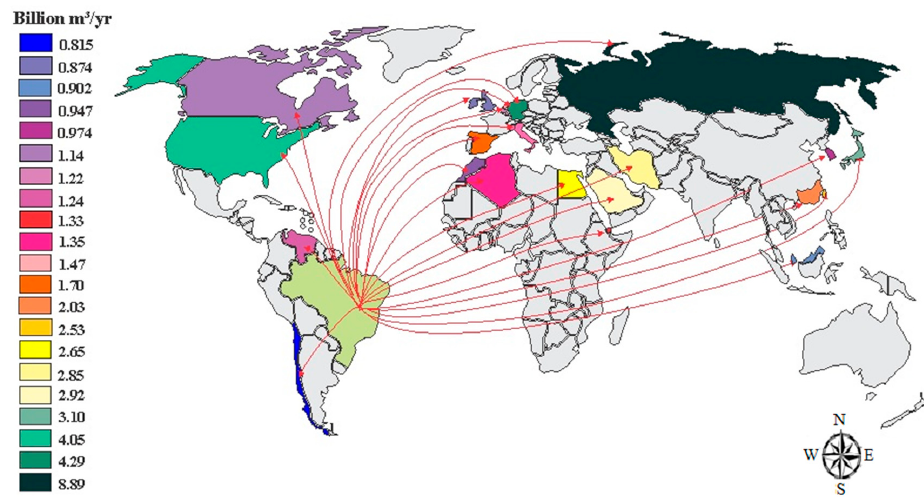
Figure 2. Gross virtual water export from Brazil related to agricultural commodities over the period